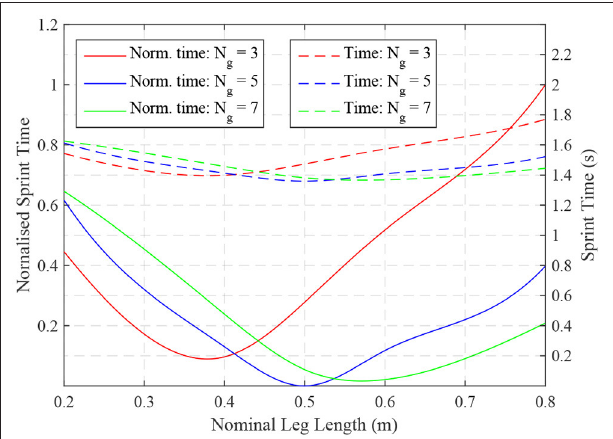
FIGURE 4 | The normalized minimum time for the long-time horizon task are shown as a function of the nominal leg length ( L n = L 1 + L 2 ) and gear ratio ( N g ) used in different models. It can be seen that large gear ratios improve performance with longer links. However, the optimal configurations of each gear ratio and leg length varies by roughly 0.5 s. From this a gear ratio of 5 with a nominal leg length of 0.5 m was chosen for the Baleka